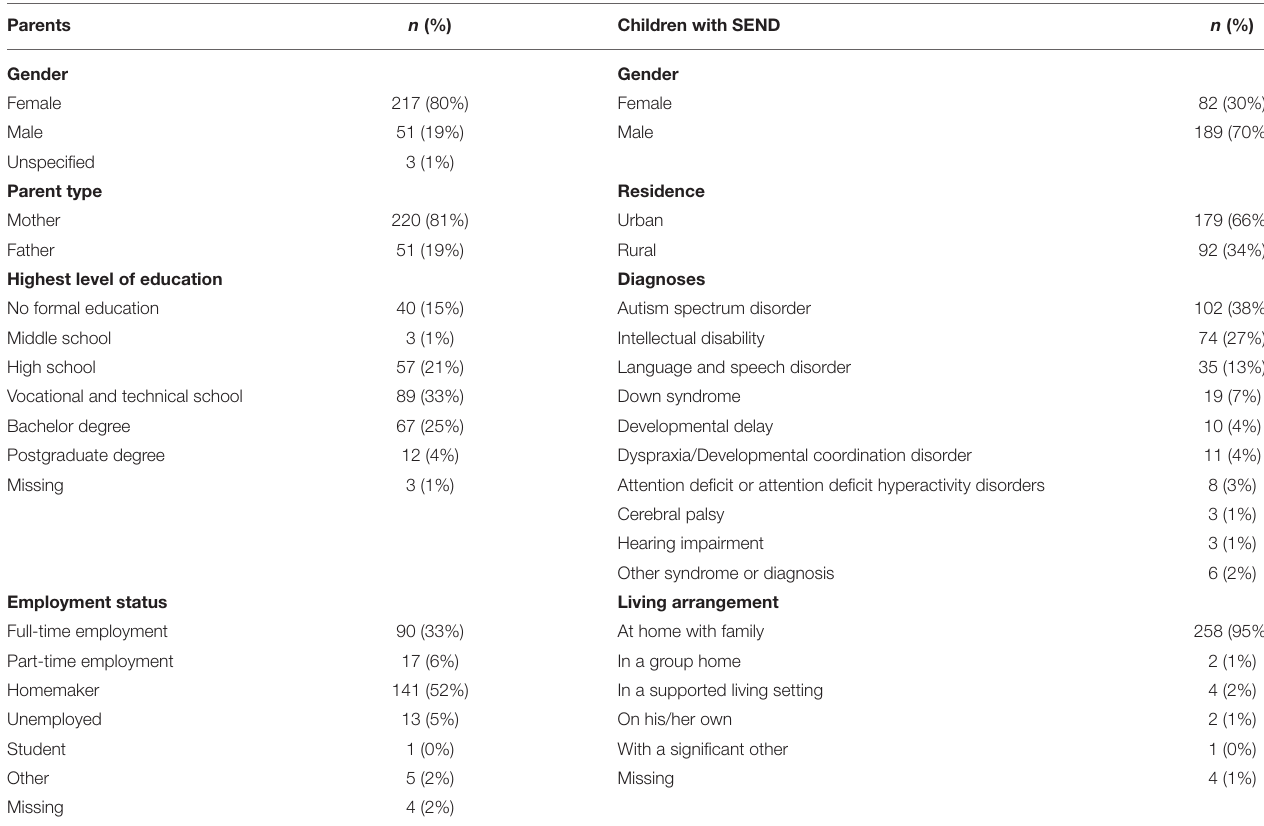
TABLE 1 | Demographic information of parents and children with